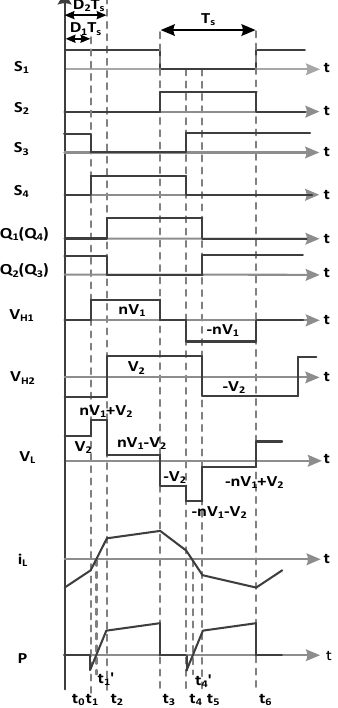
Figure 2. The main circuit waveform in one cycle.